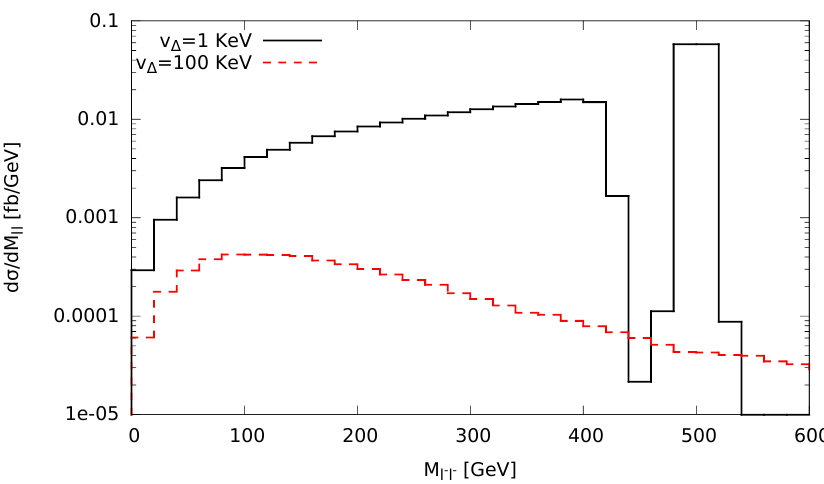
Figure 18 . Invariant mass distributions of same-sign lepton pairs after the acceptance cuts in eqs. (3.7){(3.9). In the simulation of the same-sign lepton pairs invariant mass distribution, we have considered both the pair and associated production of triply and doubly scalars namely, pp ! (cid:1) +++ (cid:1) (cid:0)(cid:0)(cid:0) ; (cid:1) ++ (cid:1) (cid:0)(cid:0) ; (cid:1) +++ (cid:1) (cid:0)(cid:0) and (cid:1) ++ (cid:1) (cid:0)(cid:0)(cid:0)